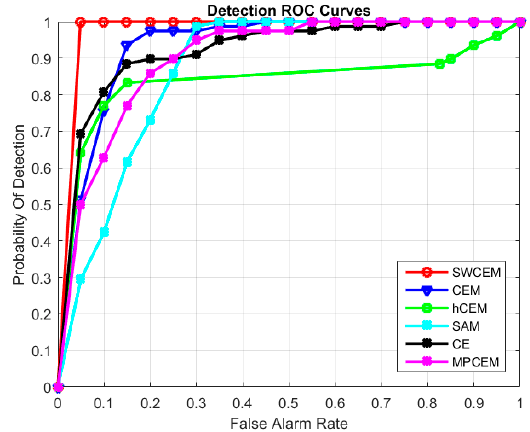
Figure 13. ROC curves of different algorithms on the Chanba Area data.